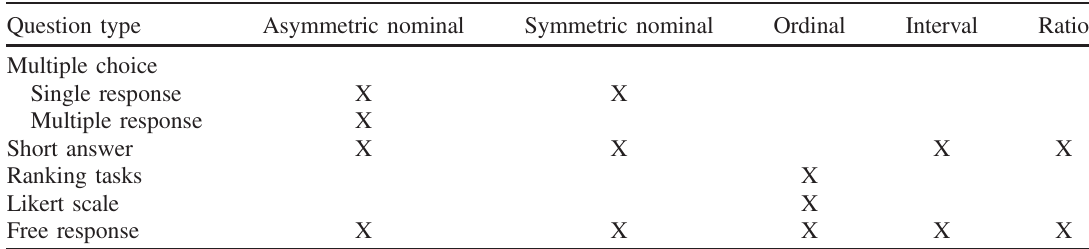
TABLE I. The natural line up between data types and question